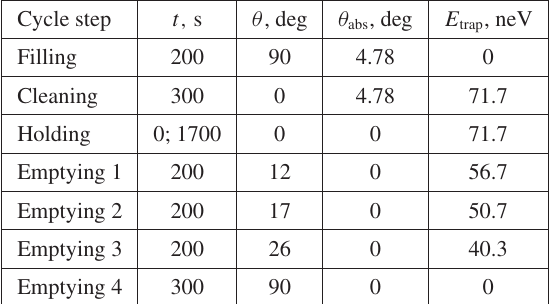
Table 2. Parameters of the measurement procedure without monitoring but with the absorber. E trap is the gravitational trap barrier at the quoted trap rotation angle θ .